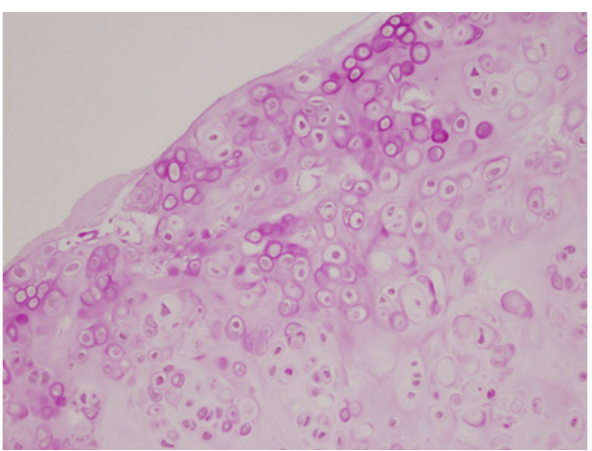
Fig. 5. Chondrosarcoma of soft tissue, that contained only target-like malignant chondrocytes in all its parts. HE, x50.